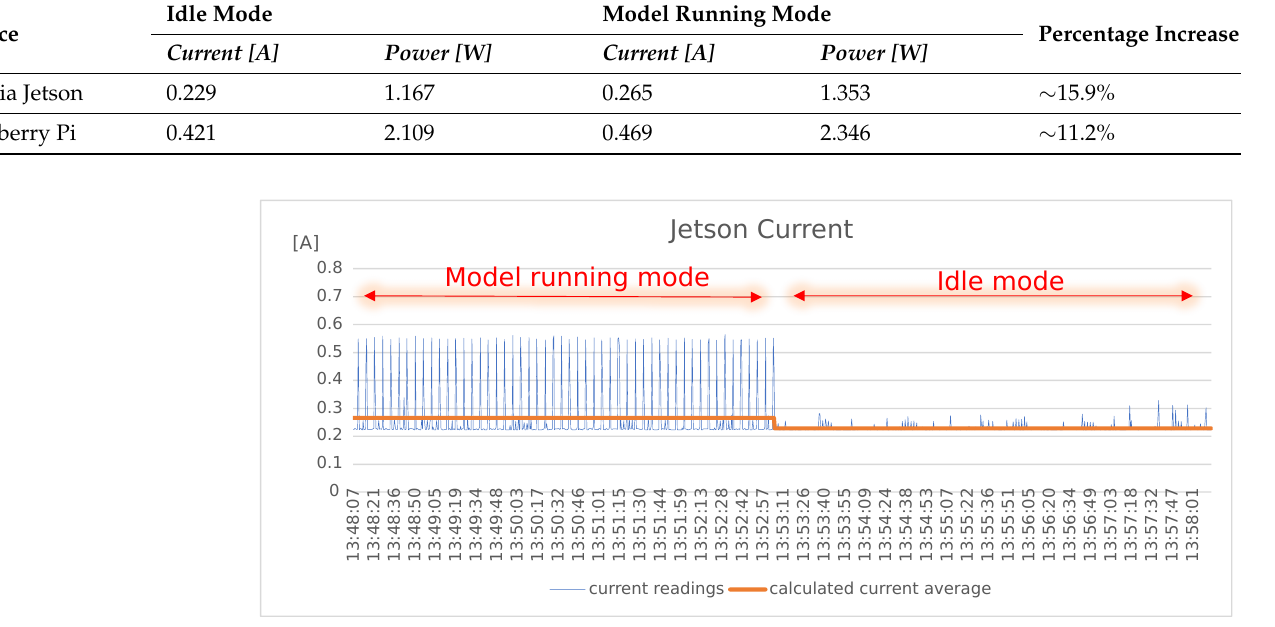
Figure 15. Variation in current consumption for ML model in Jetson; (y → current [A], x → time).